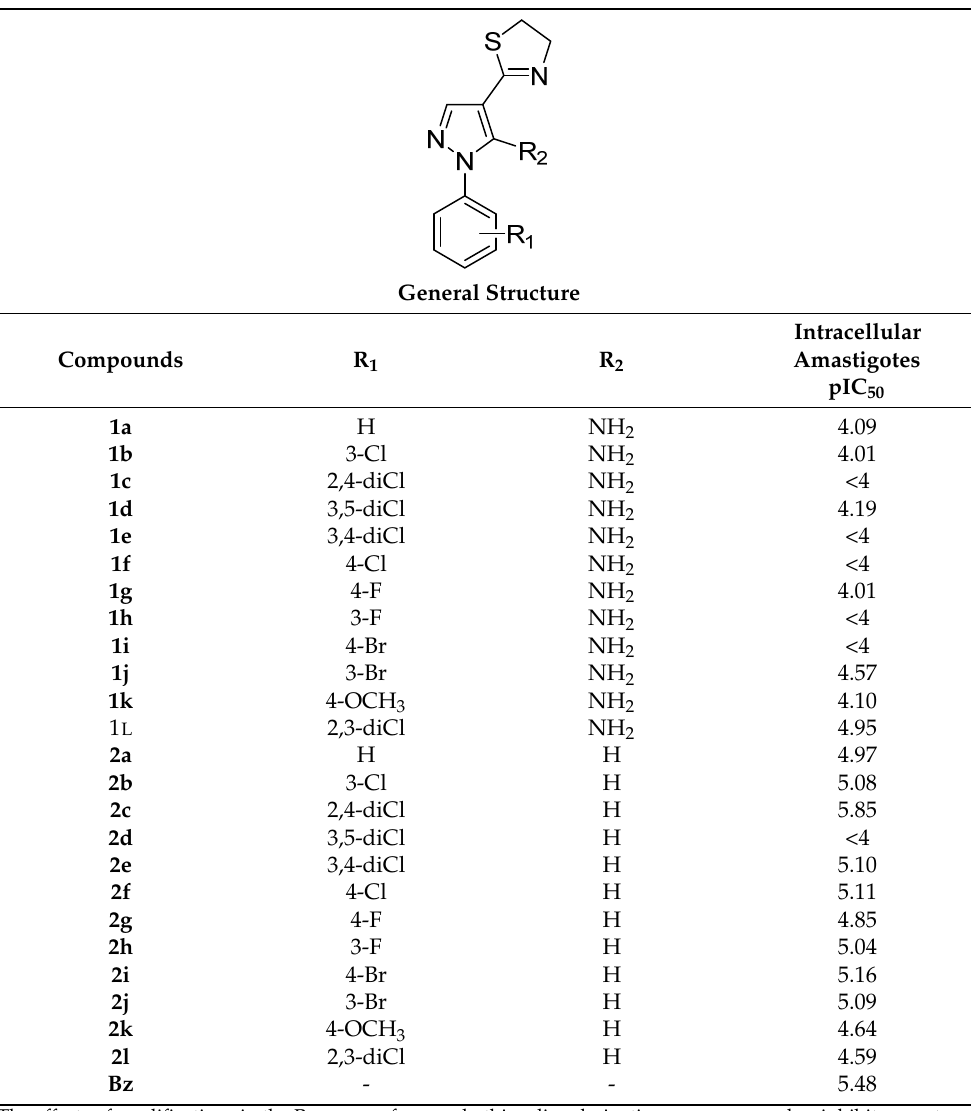
Table 2. Structure–activity relationship (SAR) analysis of pyrazole derivatives.